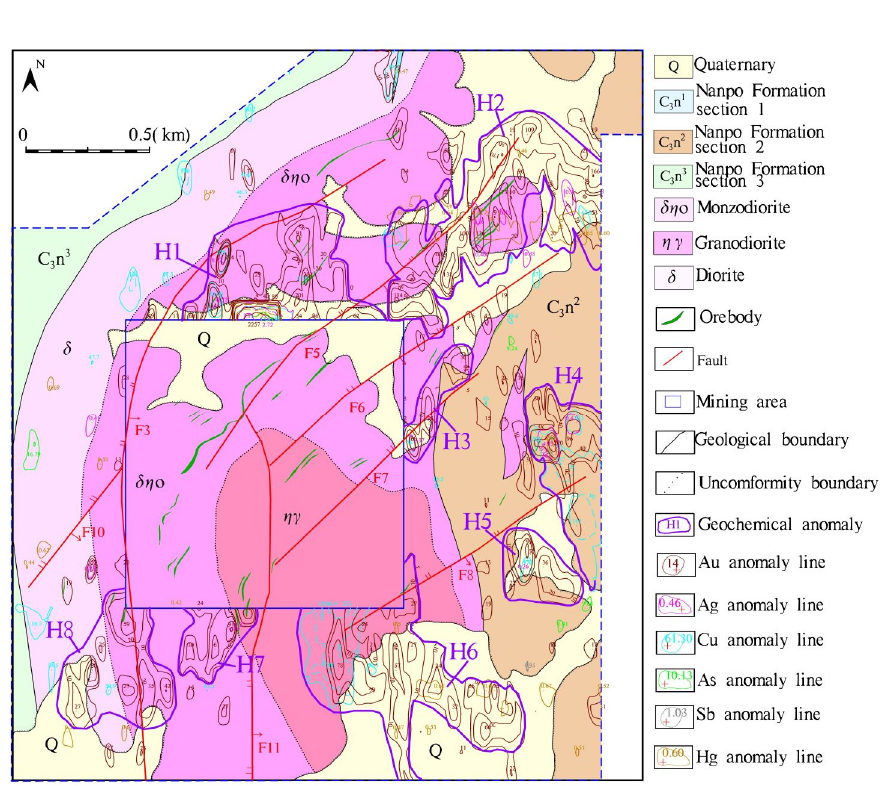
Figure 3. Comprehensive geochemical anomaly map of the soil in the Nanpo gold deposit.